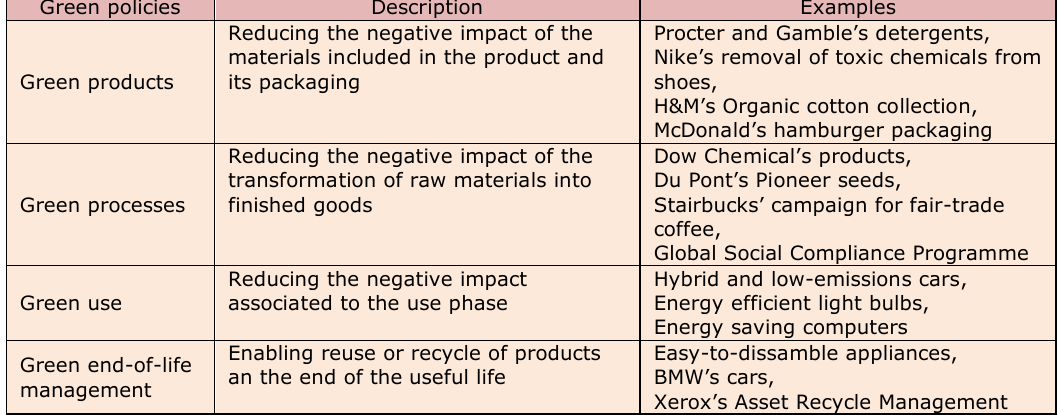
Table 2. Forms of green